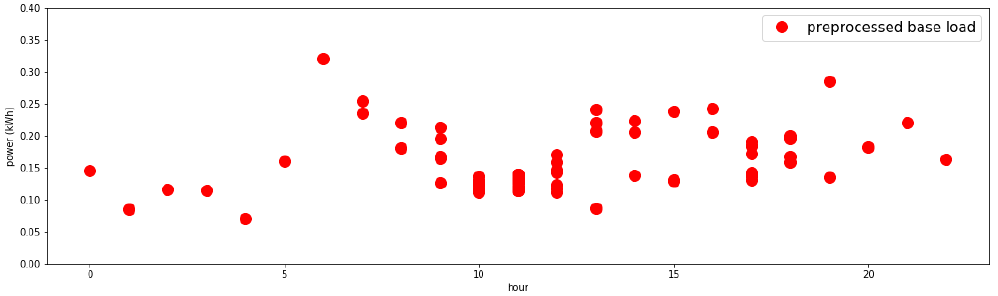
Figure 6. Sample user’s base load by time (pre-processed).